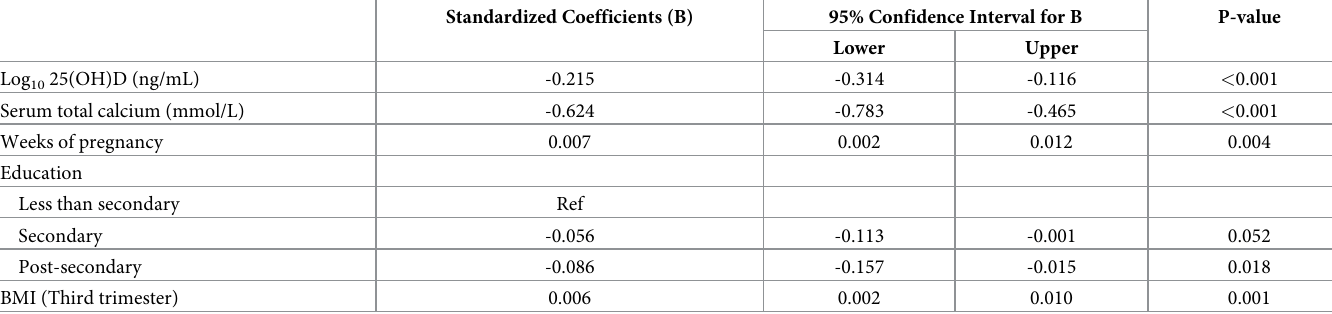
Table 3. Determinants of Log 10 PTH (transformed PTH) concentrations in the final